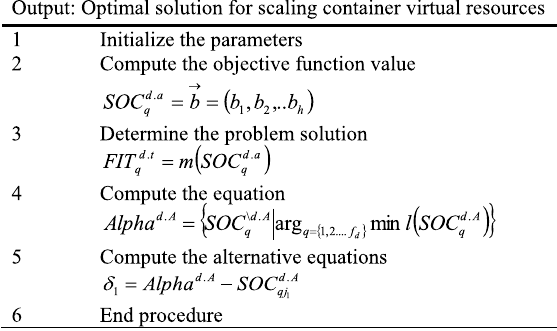
Algorithm 1 Container virtual resources scaling using MMCO algorithm Task clustering using modified pigeon‑inspired optimization (MPIO)